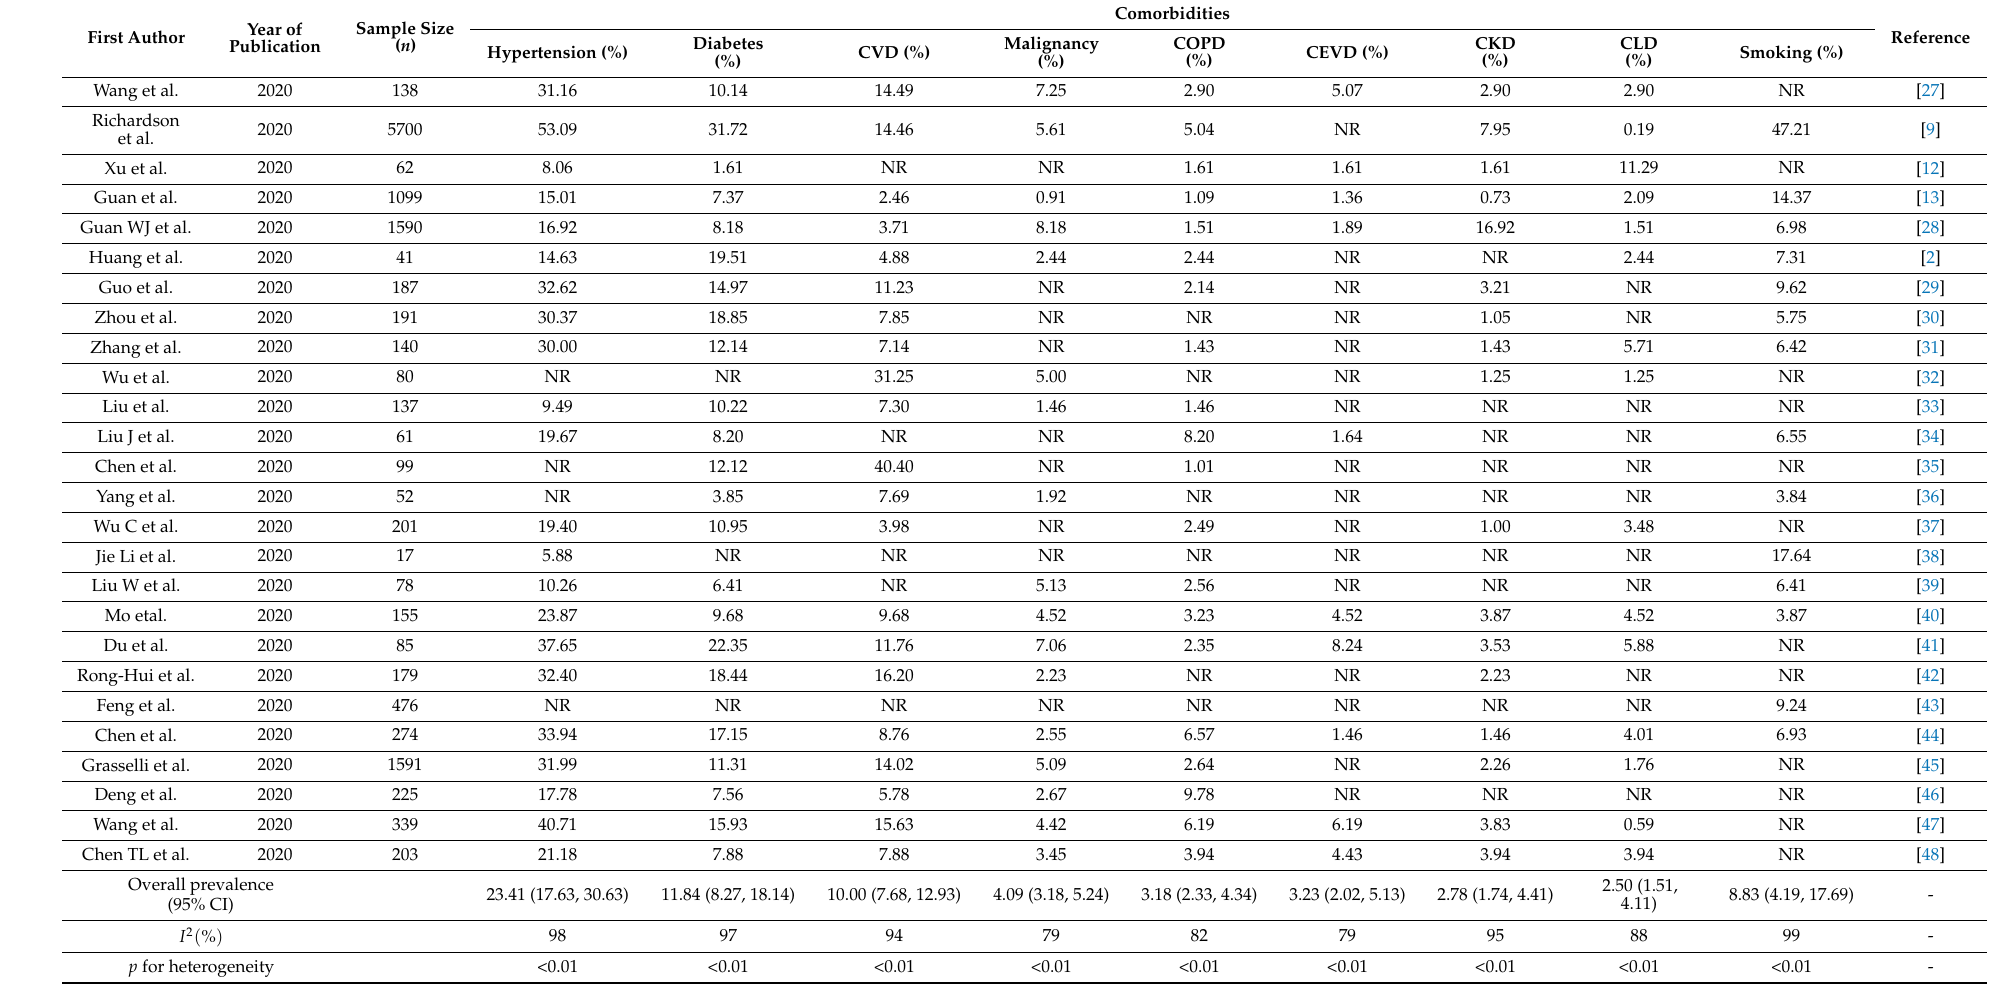
Table 3. Prevalence of comorbidities in COVID-19 patients in the selected